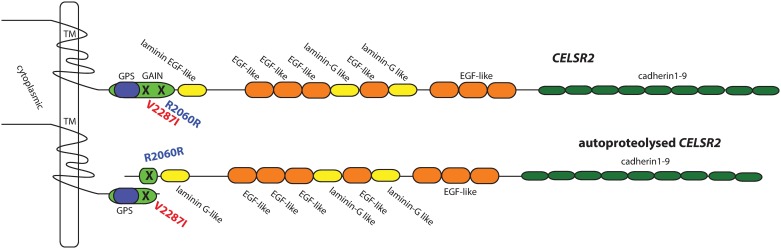
Schematic of the structure of the CELSR2 protein.Shown are the cadherin, EGF-like, and laminin-G-like domains. Also the transmembrane (TM) 7-pass domain and the evolutionarily conserved GAIN domain. The GAIN domain contains within it a GPS domain and is the site of autoproteolytic cleavage of CELSR2. The rare V2287I variant and more common R2060R tagging variant are both located within the GAIN domain.